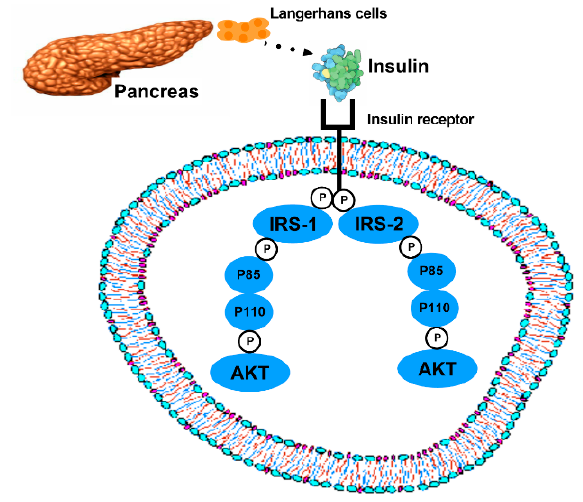
Figure 1. PI3K pathway . Insulin is produced in the Langerhans cells of the pancreas. Insulin binds to its receptor, which phosphorylates (p symbols) several substrates, but just two of them acts directly in glucose metabolism (IRS-1 and IRS-2). Thereafter, PI3K molecule, which is a dimer compound by P85 and P110 proteins, is also phosphorylated and activates